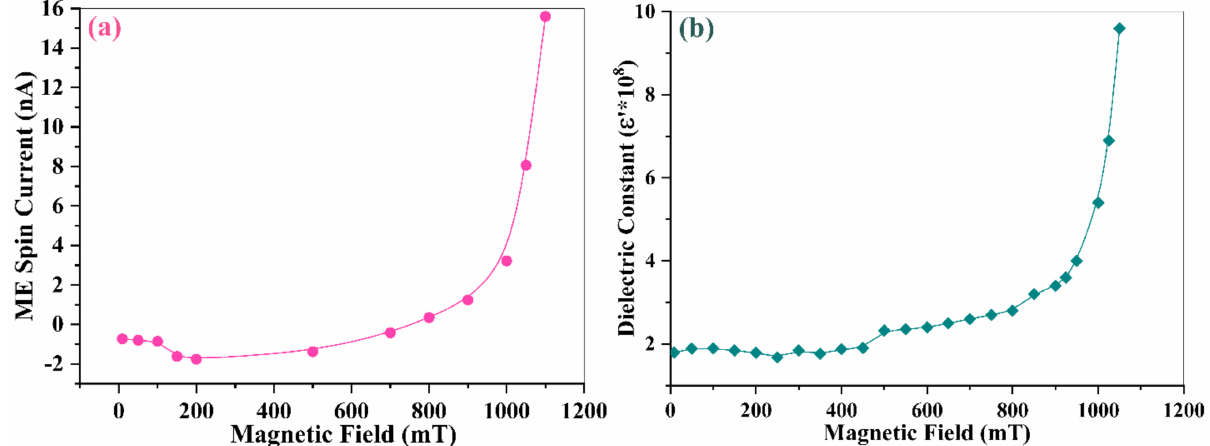
Figure 8. The magnetoelectric coupling performance of La 0.5 Sr 0.5 Fe 12 O 19 ceramic specimen: ( a ) varia- tion of spin current with magnetic field and ( b ) change in dielectric constant upon different magnetic fields at 50